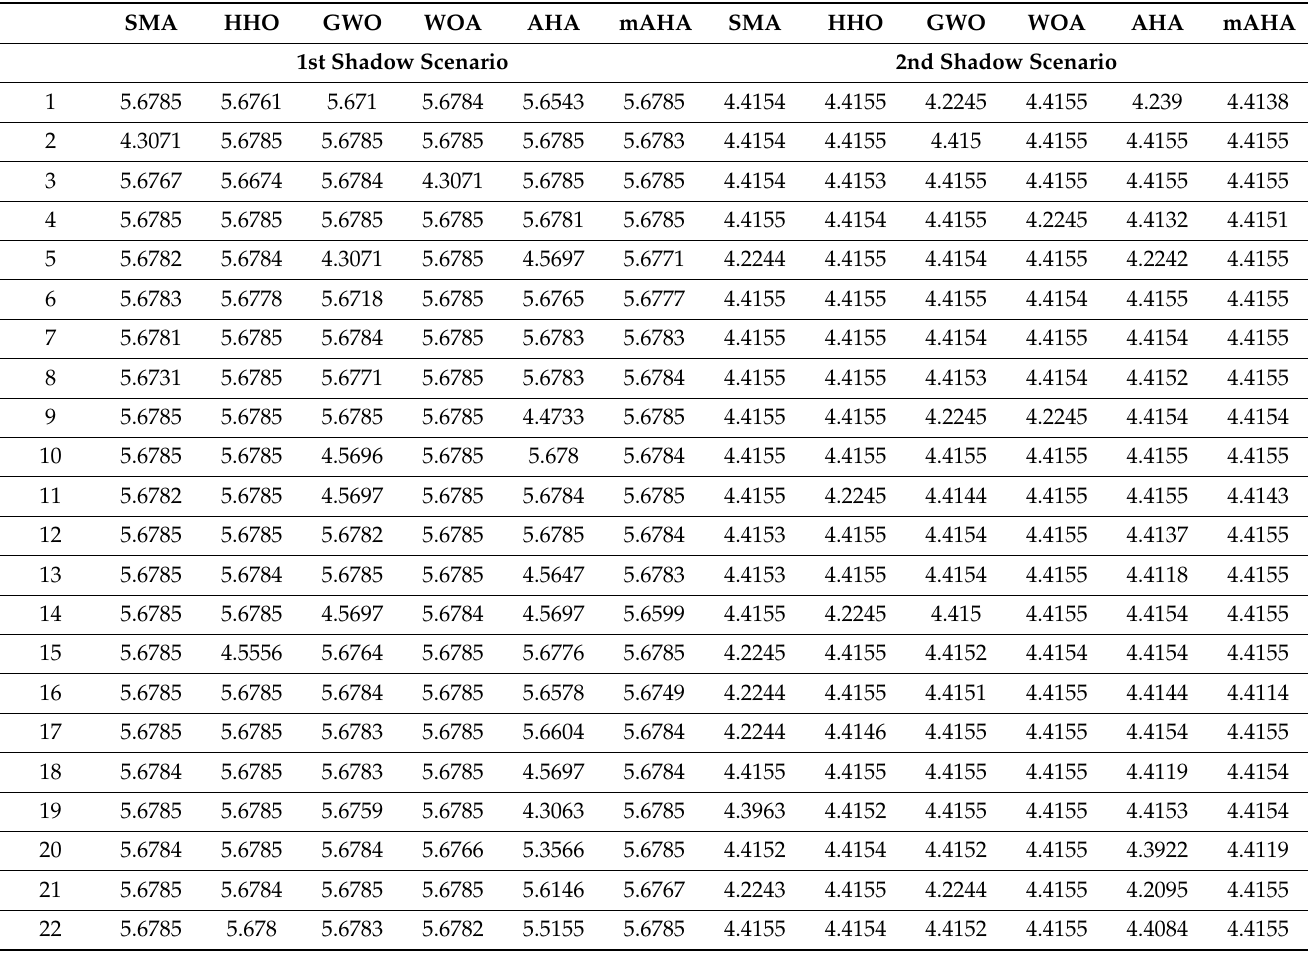
Table 7. Cost function values during optimization